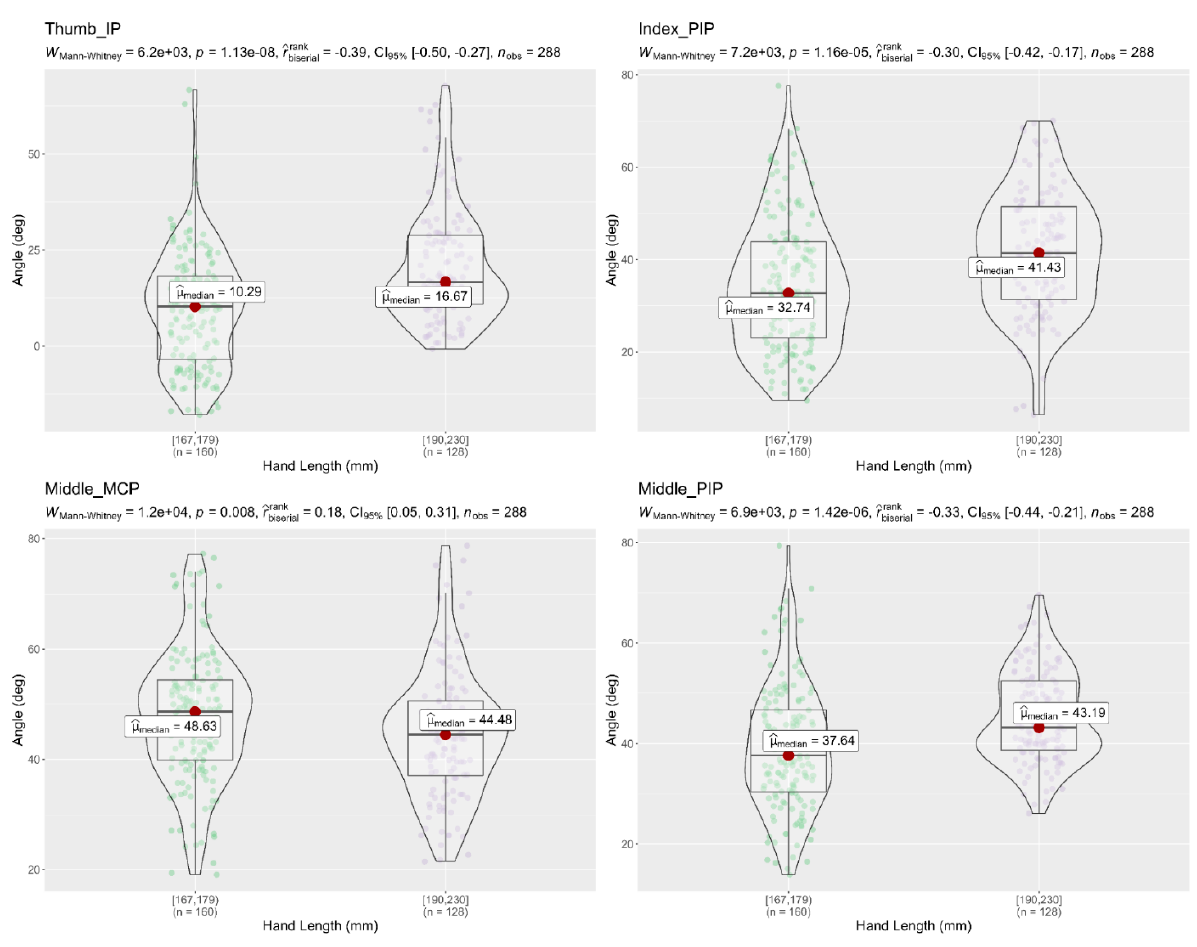
Figure 9. Mann–Whitney U test of flexion angle in finger joints with respect to different hand length groups; The figure only shows the finger joints in which significant differences were found (Thumb IP, Index PIP, Middle MCP, Middle PIP); p < 0.05, significantly different; deg = degrees. Table 7. Descriptive statistics of fingertip forces during the performance of the ARAT